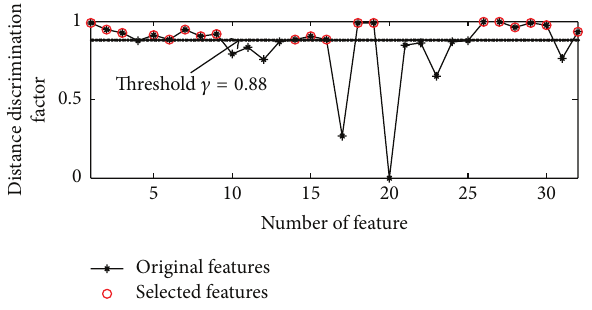
Figure 5: Salient feature parameters